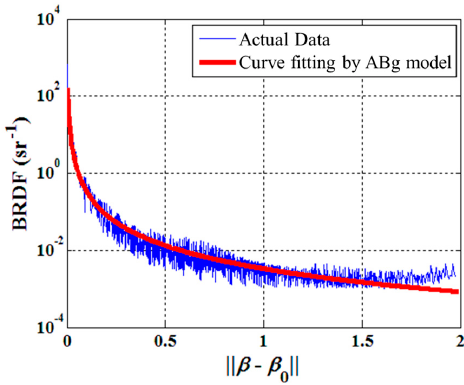
Figure 7. The fitted ABg model of aluminum.